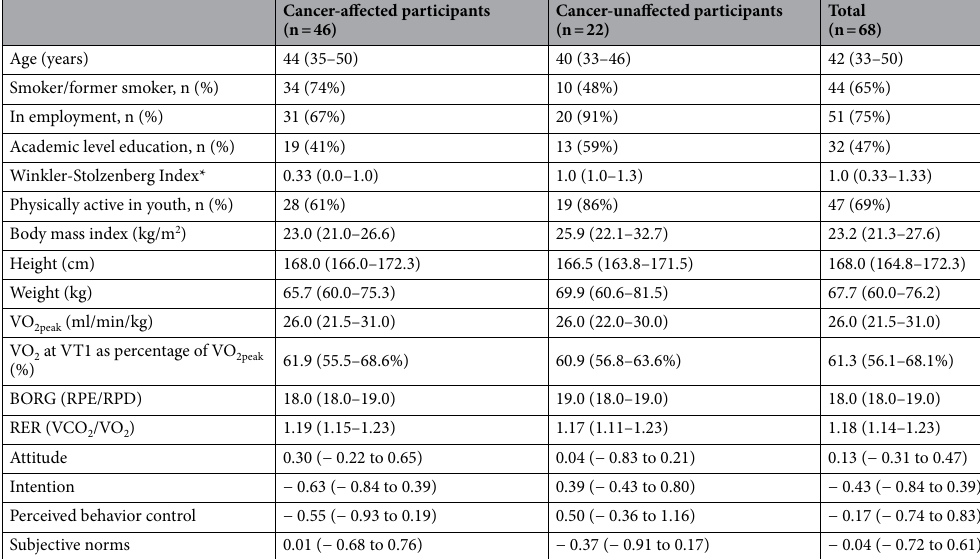
Table 1. Characteristics of the participants. Data are presented as median (interquartile range); Active in youth = those who indicated that they were exactly as active or more active than their peers from ages 10 to 19 years; BMI Body Mass Index; VO 2peak Maximal Oxygen Uptake; VT1 ventilatory threshold one; RER respiratory exchange ratio; RPE rate of perceived exertion/ RPD rate of perceived dispnoe. *Adaptation of the WSI to describes the socioeconomic status (compare method part).